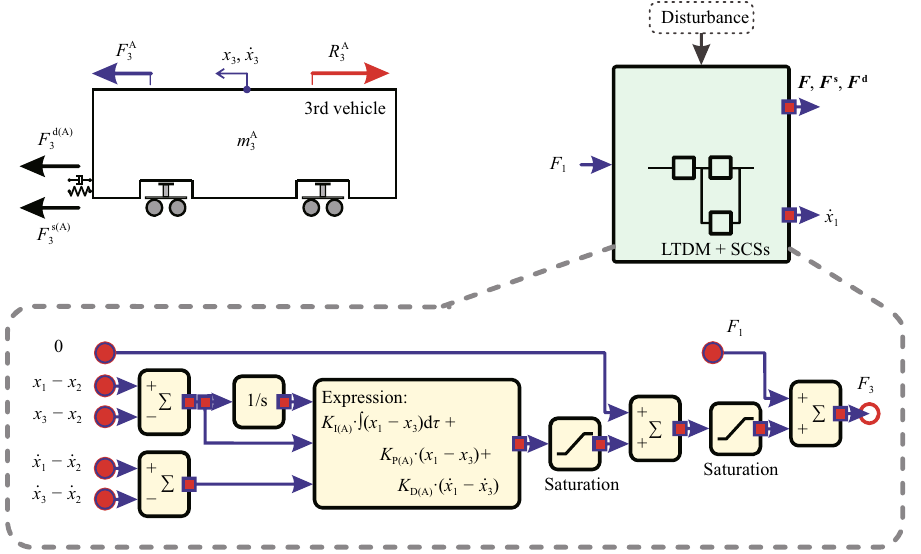
Fig. 14 Essential part of the block diagram of the slave control systems enabling the realization of the active vibration damping in the push–pull